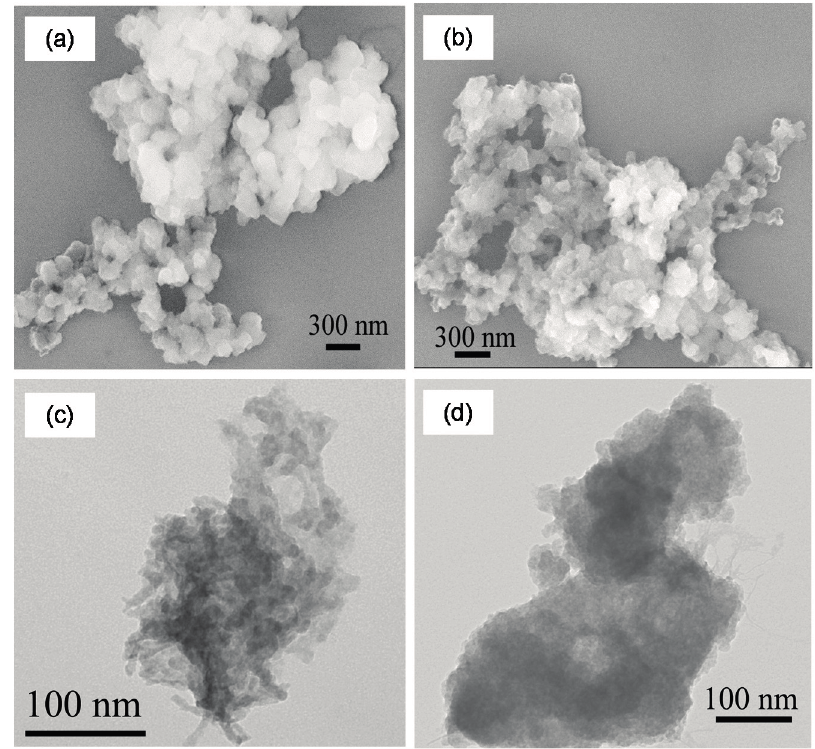
Figure 3. Microscopy images of enzymatically-synthesized magnetic nanoparticles: SEM ( a ) Fe–Gd–O; ( b ) Fe–Ho–O; and TEM ( c ) Fe–Gd–O; ( d ) Fe–Ho–O.